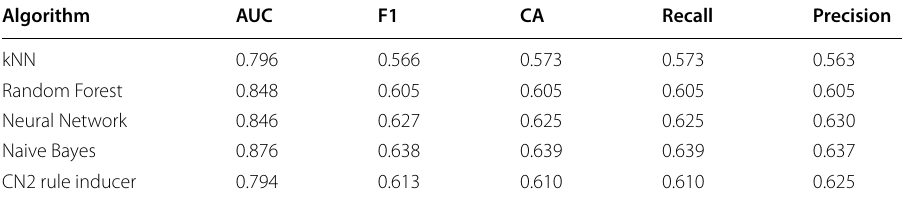
Table 17 Comparative evaluation of the performance of the data mining algorithms using Orange software